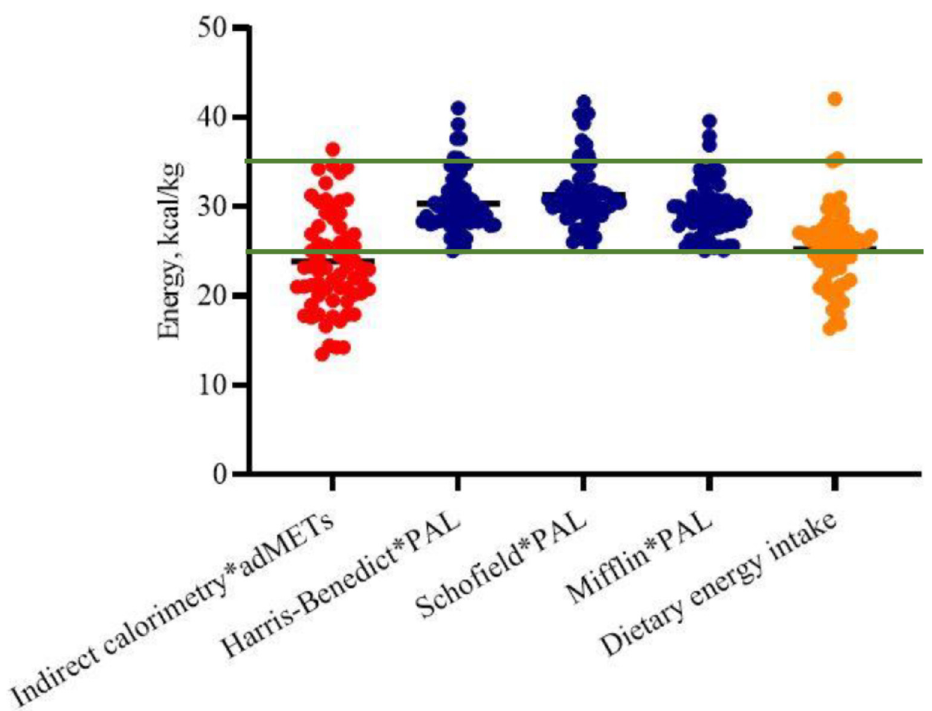
Figure 3. Measured and estimated total energy expenditure, and dietary energy intake reported per kilogram of ideal body weight. Green lines correspond to NKF-KDOQI 2020 recommendations [7].